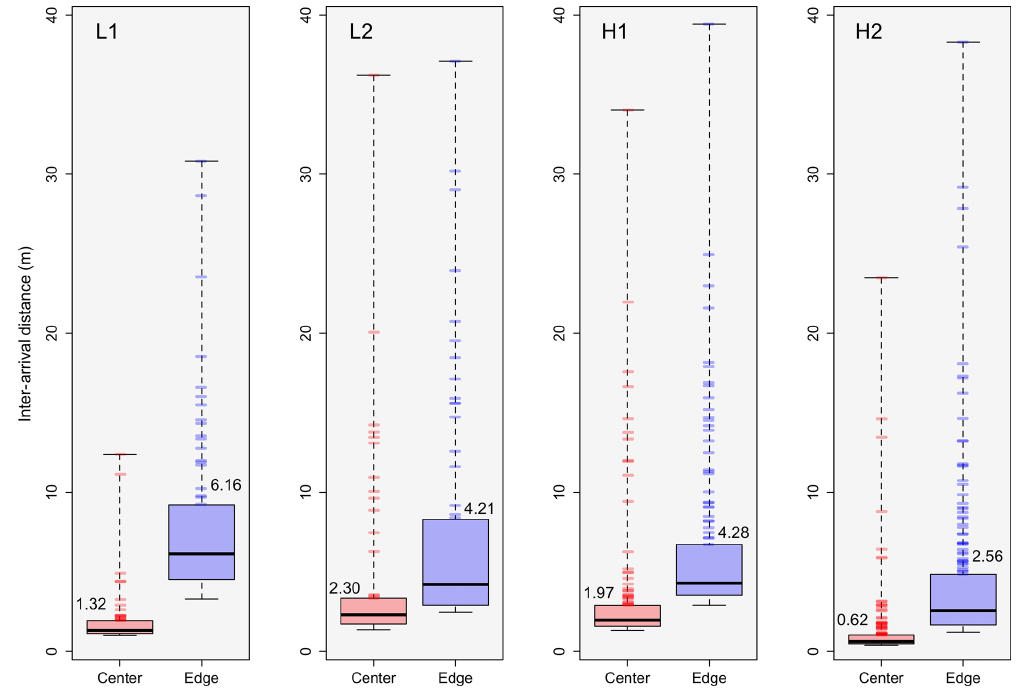
Figure 7. Box plots for the IAD data which are greater than or equal to the 0.998 quantile of the overall data sets for edge (blue) and center (red), with L1, L2, H1, and H2 shown moving from left to right, respectively. The median value for each data set is displayed within the plot. Tick marks occurring on the upper whiskers represent the raw data positions. Note that panel L1 represents the same box plot displayed in Fig. 6.